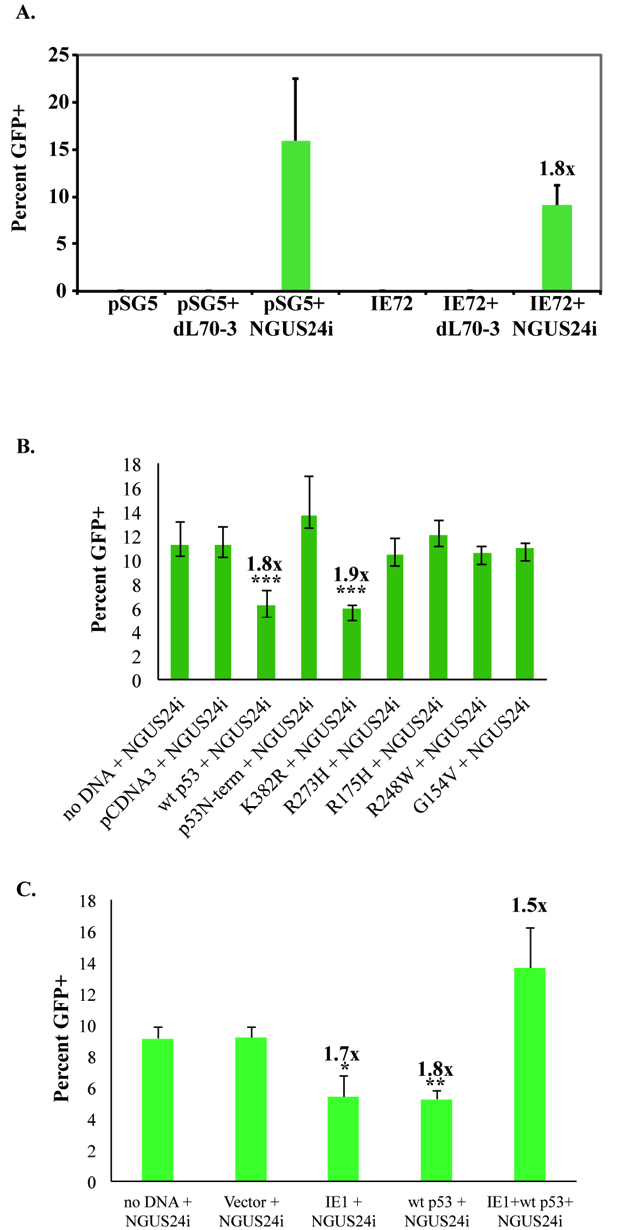
Figure 3. Nucleofection with IE72 or wt p53 alone decreased HDR, whereas co-expression did not alter high level HDR in T98Gs. Cells were nucleofected with the indicated plasmids and then infected with either I- Sce I expressing (NGUS24i) or control (dL70-3) Ad. Coverslips were harvested at 40 h post Ad infection. GFP + cells were scored as HDR competent. ( A ) Percentage of GFP + in Clone 10 after nucleofection of IE72 or pSG5 control. ( B ) Percentage of GFP + in Clone 10 nucleofected with either wt p53 or p53 mutants (K382R, N-term, R273H, R175H, R248W, G154V). ( C ) Percentage of GFP + in Clone 10 nucleofected with wt p53 and/or IE72. At least 300 cells were scored for each type of infection. Error bars represent one SD. Values on top of the bars indicate fold decrease (or increase for the dual IE72/wt p53 nucleofection) in percent of GFP + cells. *, ** and *** indicate increasing levels of statistical significance (see text for details). Error bars represent one